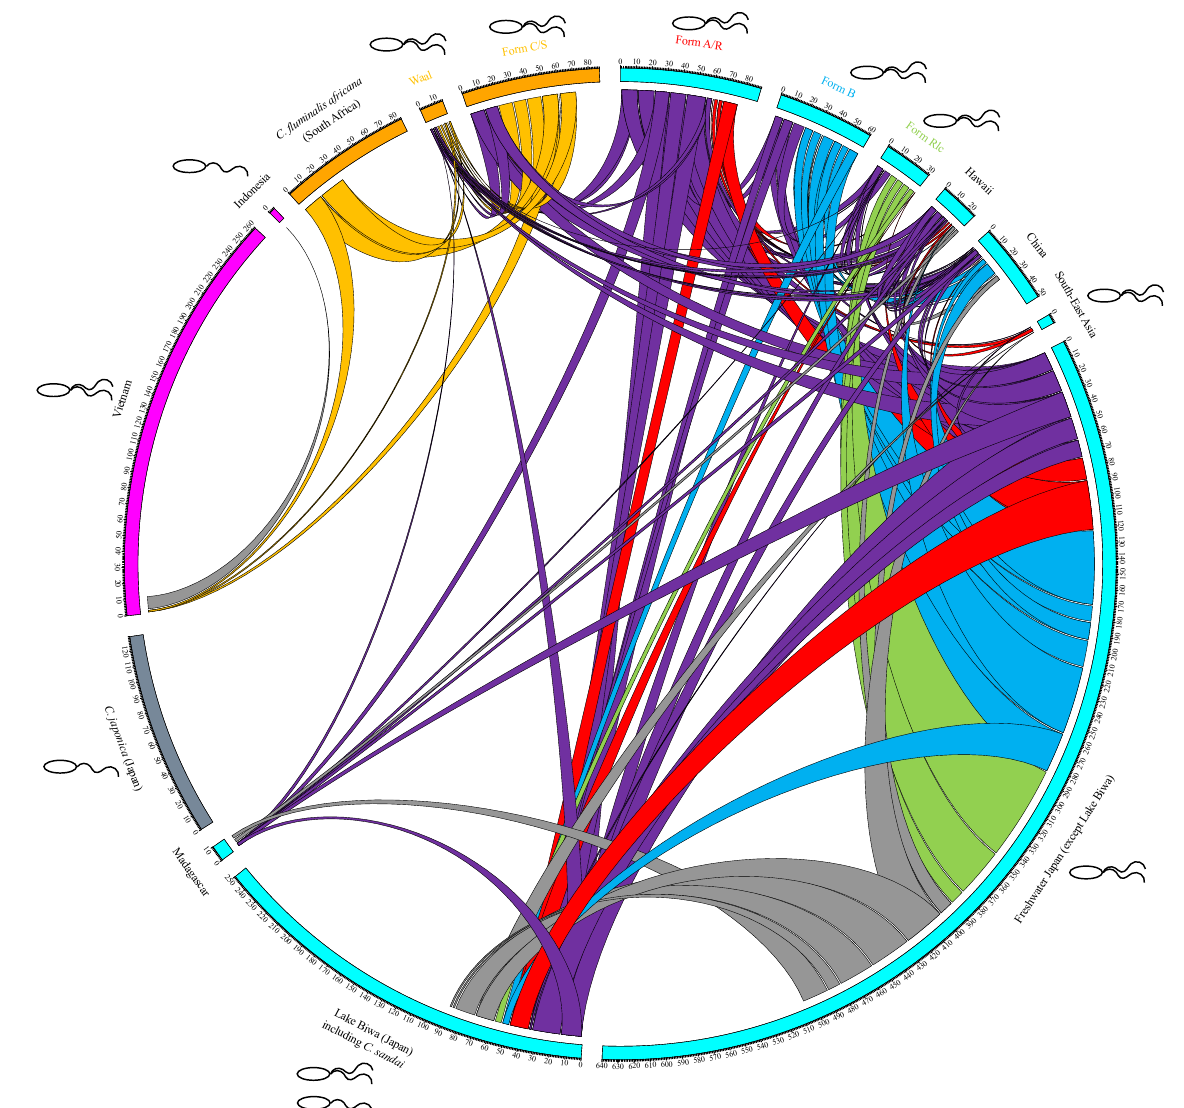
Figure 4: Circos plot representing allele sharing among Corbicula (n = 359). Groups (namely idiotypes) are represented by circle arcs with a size determined by the total number of alleles found in each group. Their colors refer to the FFR delimitation from the haplowebs (Fig. 2 and S2) and conspecificity matrix (Fig. 3) analyses. Linking lines between these groups represent shared alleles, with the thickness proportional to the number of occurrences of this allele in each population. The line color refers to alleles found in invasive lineages (Table S2), with exclusive alleles from C. sp. form A/R, B, C/S, and Rlc in red, blue, orange, and green, respectively, non-exclusive alleles in purple, and alleles restricted to the native range in grey. When it is known, the occurrence of sexual and androgenetic lineages is represented by mono- and biflagellate spermatozoa, respectively, for each group. For Hawaii, China, Madagascar, and South Africa idiotypes, the reproductive mode is